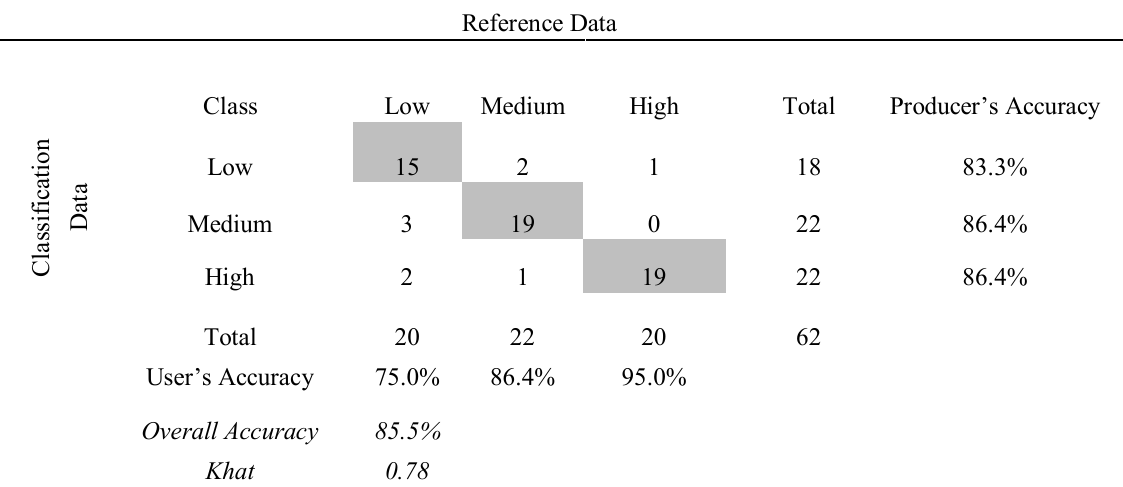
Table 4. Classification accuracies summarized in a confusion matrix for each hierarchical level. Level II: Validation of Seedling Densities.